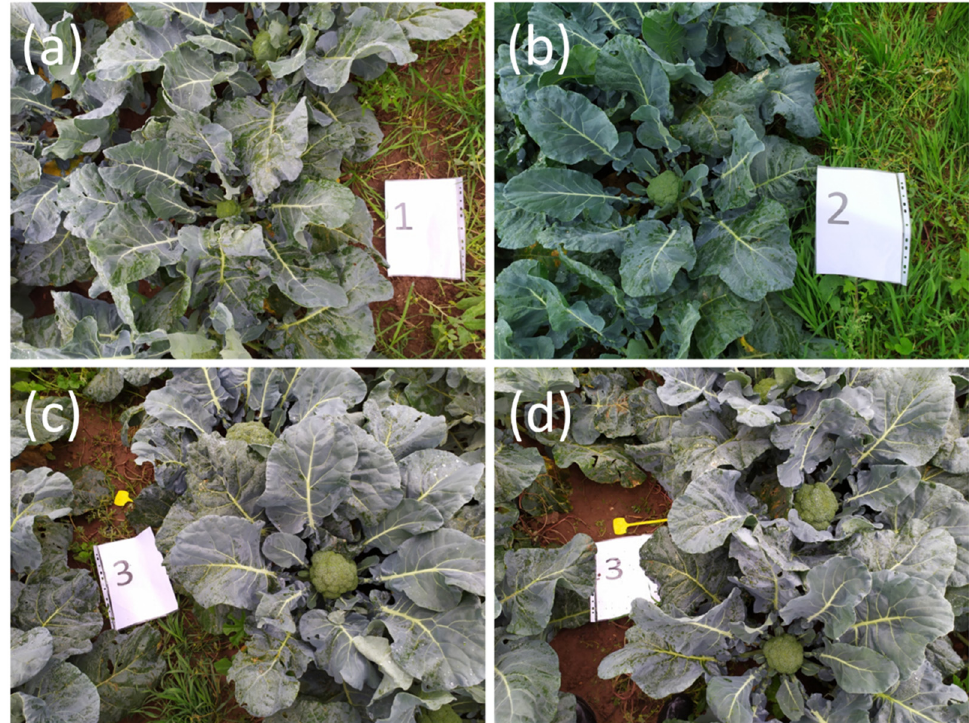
Figure 5. The ground truth targets for each plant’s maturity class and their respective pointers (when deployed, in high plant coverage areas). ( a ) Maturity class 1; ( b ) maturity class 2; ( c ) and ( d ) maturity class